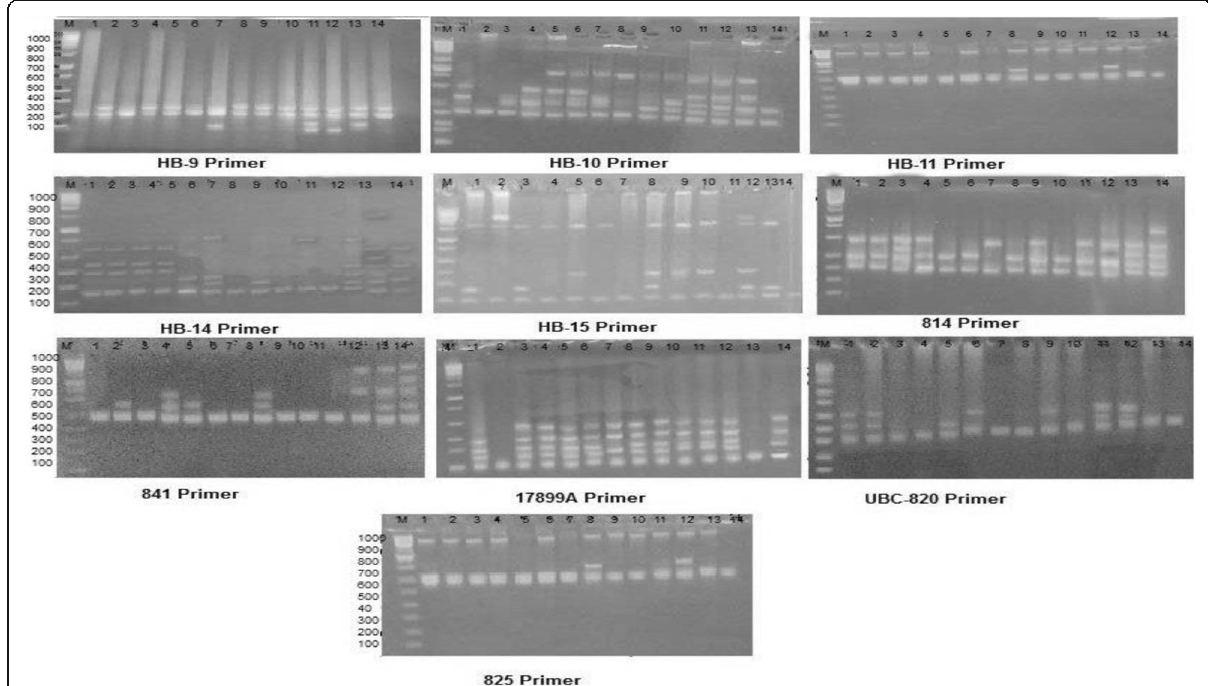
Fig. 2 ISSR profile of the 14 samples of Silybum marianum generated by ten primers